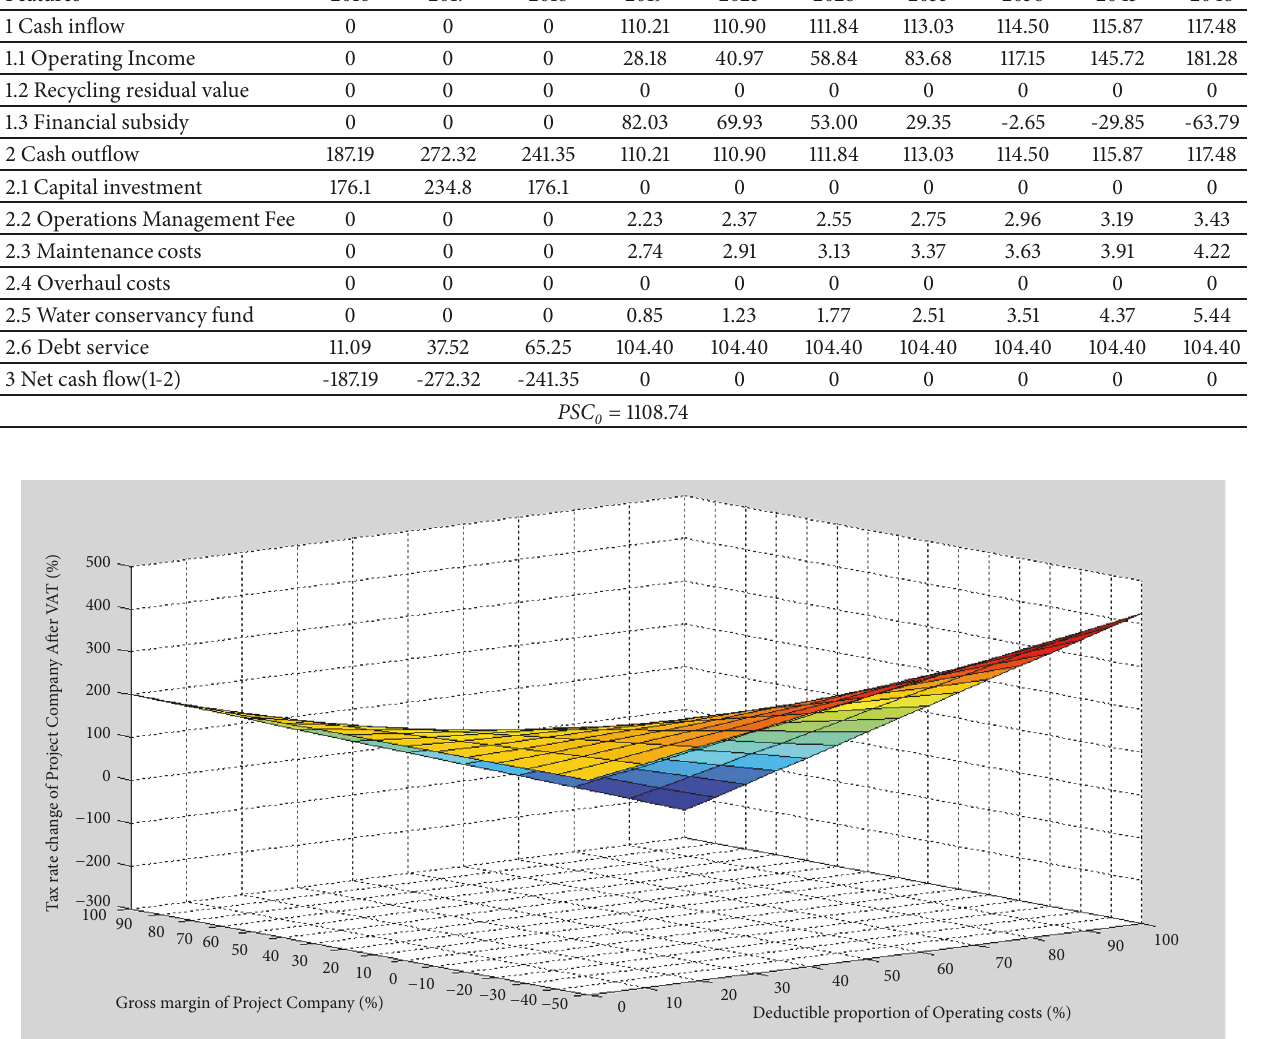
Table 4: The calculation process of PSC